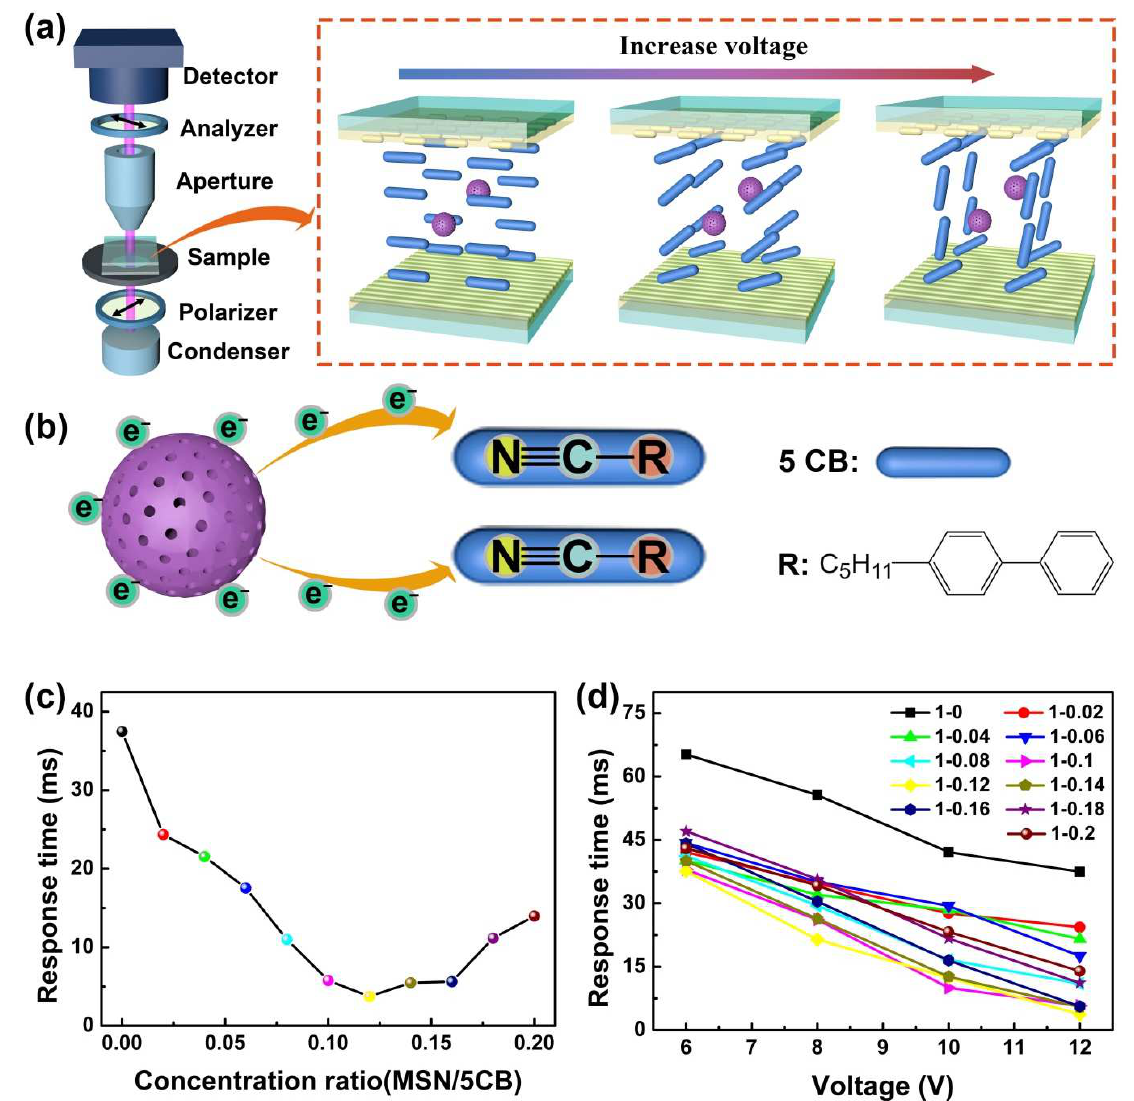
Figure 5. ( a ) Schematic diagrams of the electro-optic setup and electrical switching of LCs and MCNs. ( b ) Schematic diagrams of the charge transformation process between the MSNs and LC molecules. ( c ) Response time for LC cells doped with different of MSNs concentrations. ( d ) Response time vs. applied electric field for pure 5CB and MSN/5CB composites.